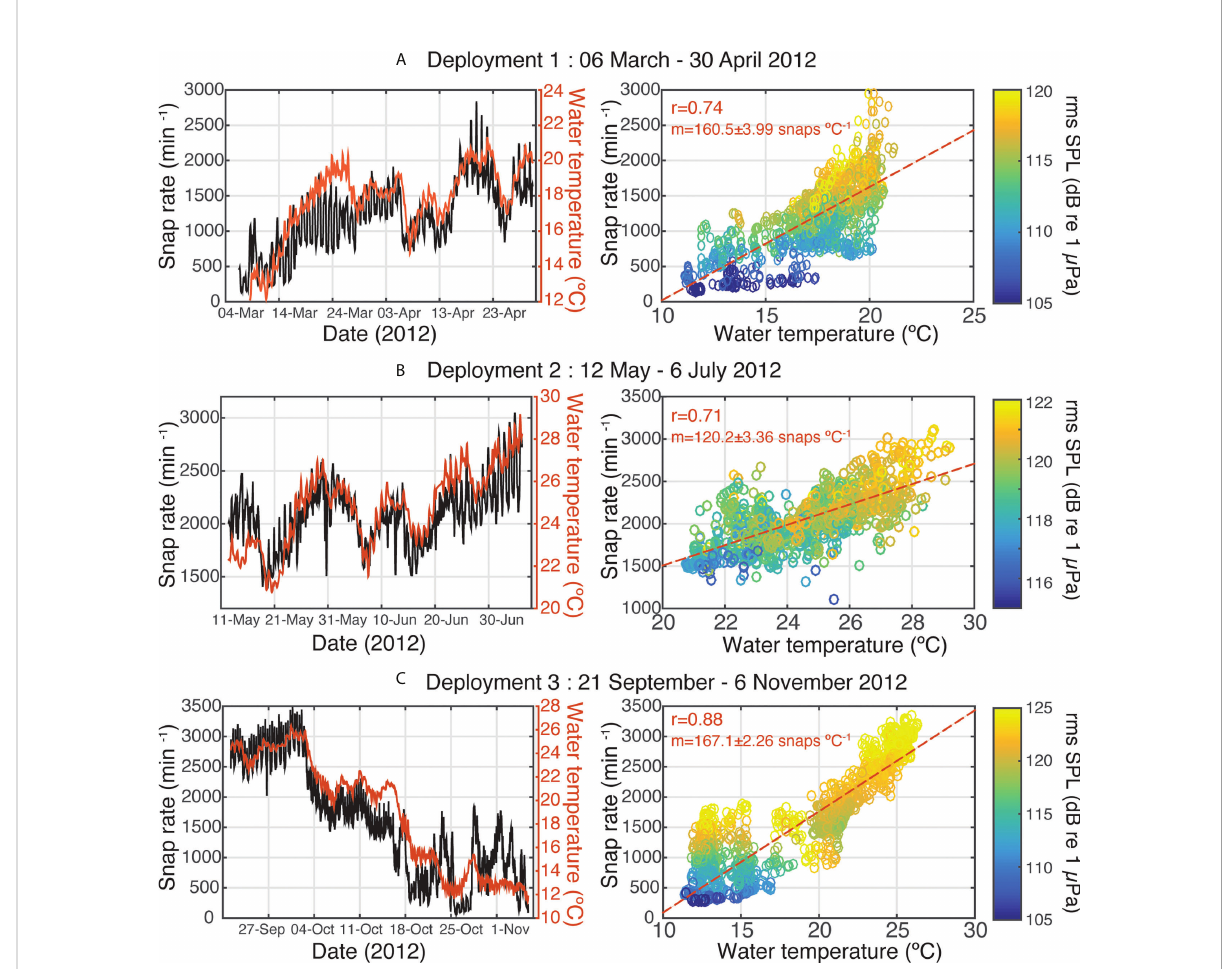
FIGURE 2 Time series and correlations of snap rates and water temperatures for 2012 deployment periods (A) 1, (B) 2, and (C) 3. Correlation plots show snap rate vs. water temperature with color indicating the measured root-mean-square sound pressure levels for each sample. Red lines are least squares fi ts to the data, and the correlation coef fi cients and slopes are displayed on each